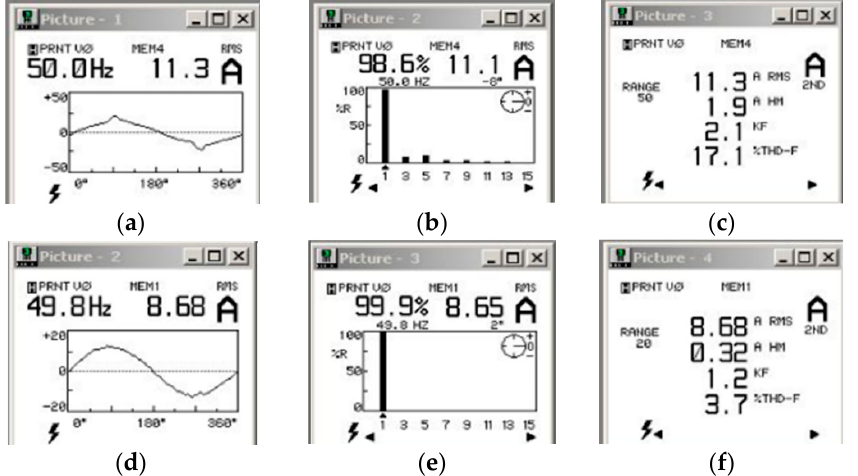
Figure 16. Harmonic spectra of currents on phases A ( a ) and C ( b ): downstream of the PCC (in black); upstream of the PCC (in red).